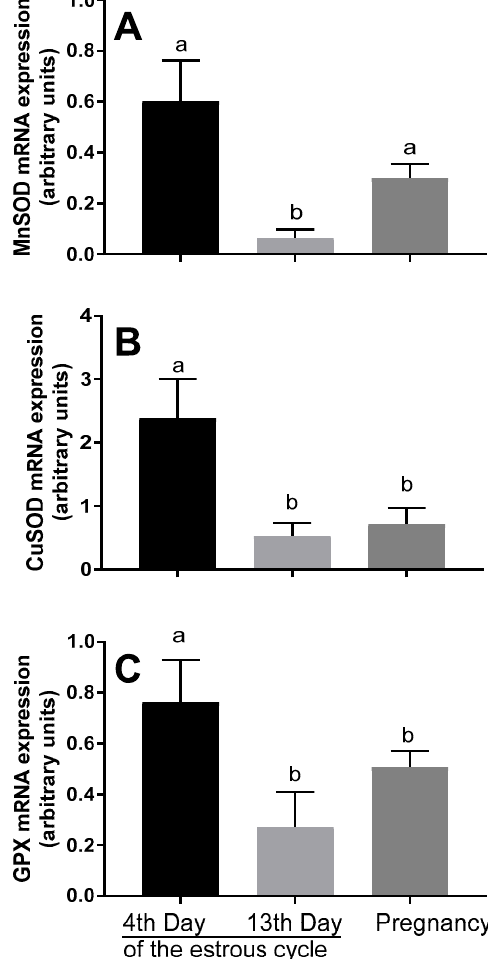
Figure 3. mRNA expression of MnSOD ( A ), CuSOD ( B ), and GPX ( C ) in red deer blastocysts developed from the oocytes collected on the 4th day versus the 13th day of the estrous cycle versus during pregnancy, as determined by real-time PCR. Data were normalized against the mRNA expression of the internal control gene GAPDH . Bars represent the mean ± SEM. Di ff erent letters (a, b) indicate statistically significant di ff erences. p < 0.05 was considered statistically significant.